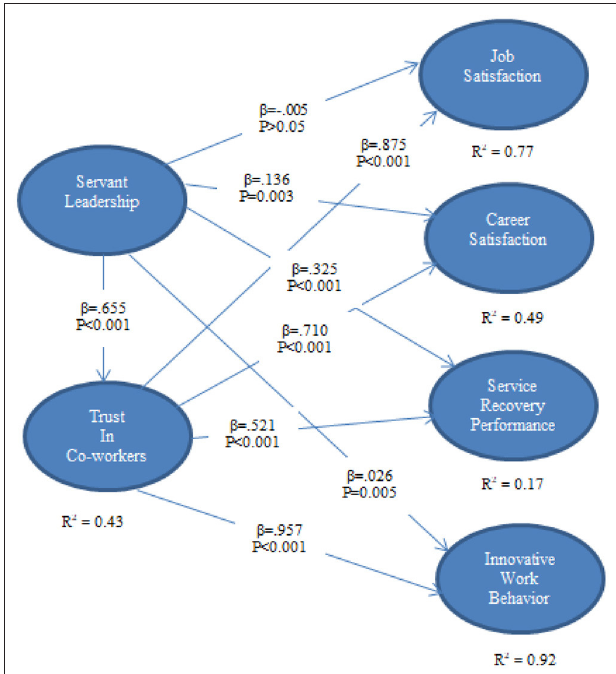
FIGURE 2 | Model testing with